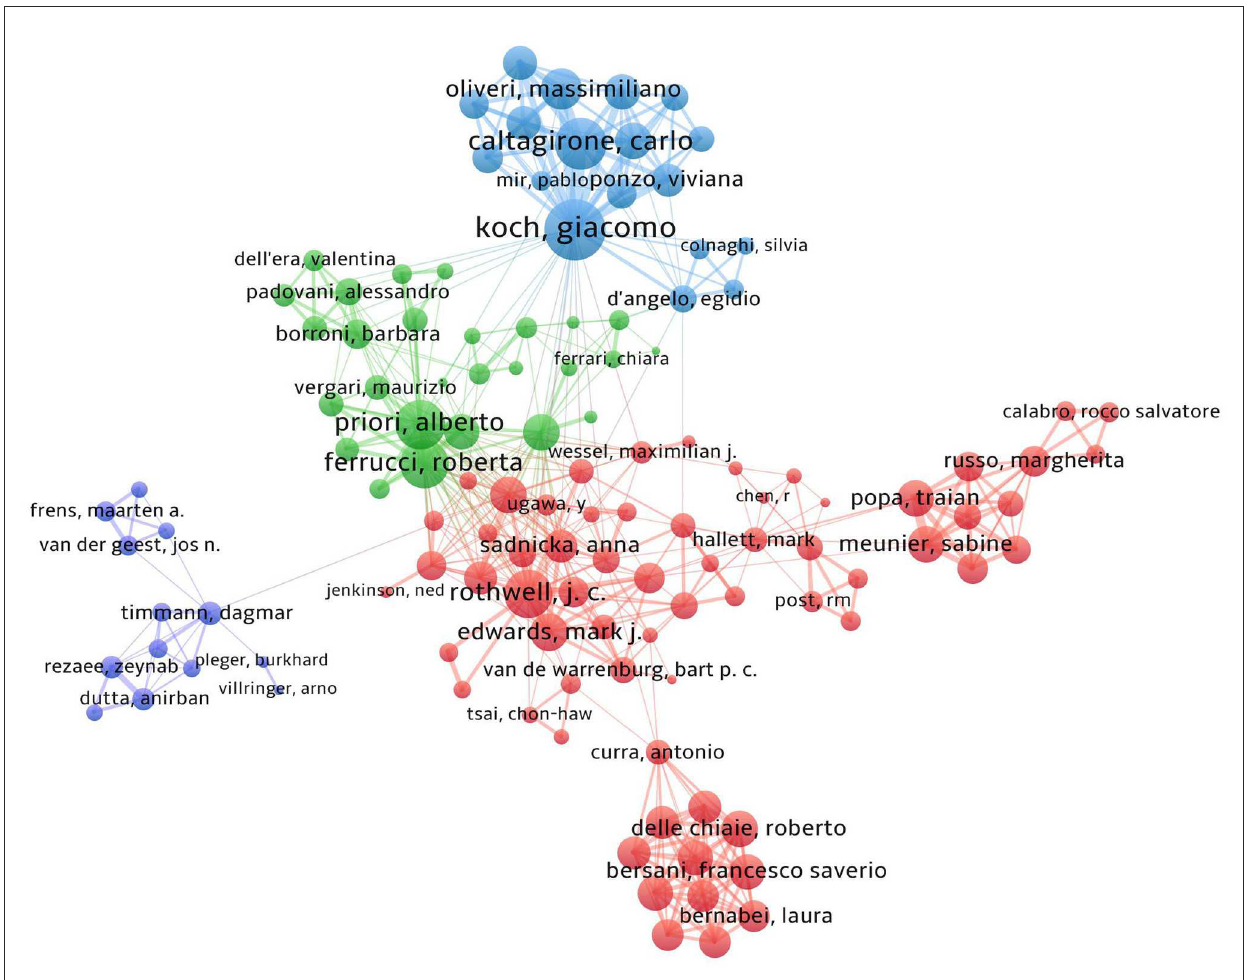
FIGURE8 The co-authorship network map of authors in NICS field. Node size represents the number of publications, and the line between any two nodes indicates the cooperation